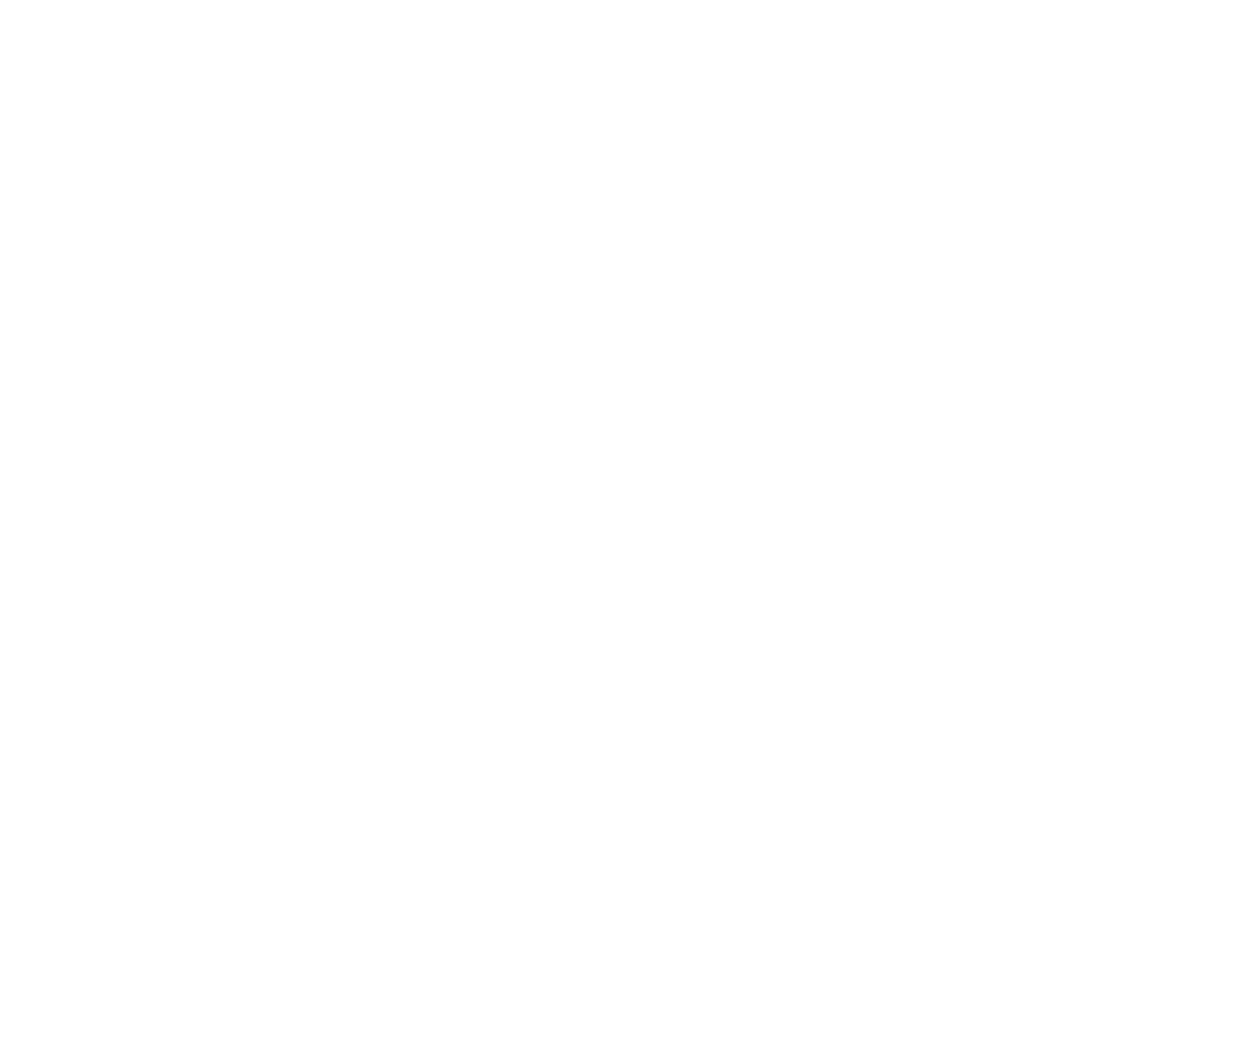
Frontiers in Pharmacology |